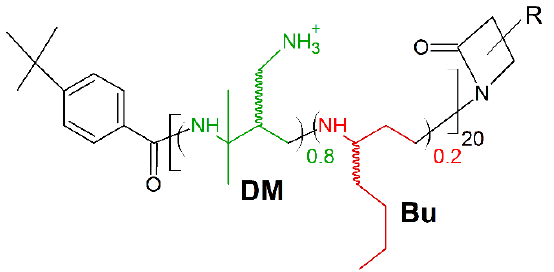
Figure 10. Schematic representation of 80:20 DM:Bu polymer. Green: positively charged monomer; red: hydrophobic monomer.